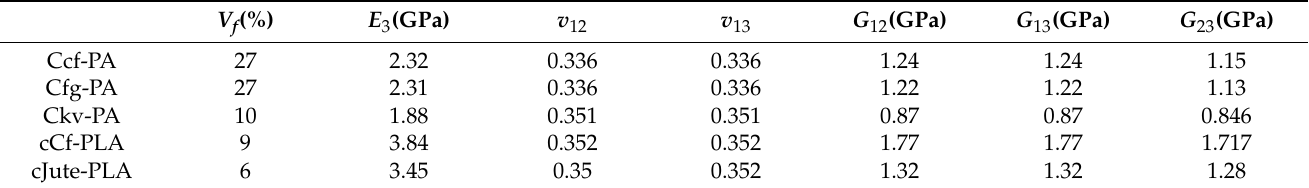
Table 4. Suggested values of the engineering constants in continuous FRAM